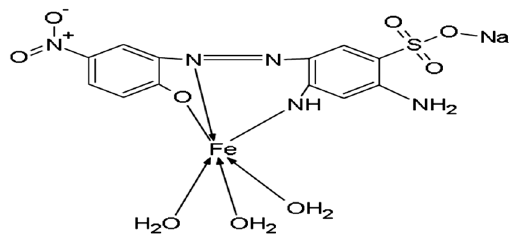
Figure 1. Chemical Structure of Brown 706 dye.